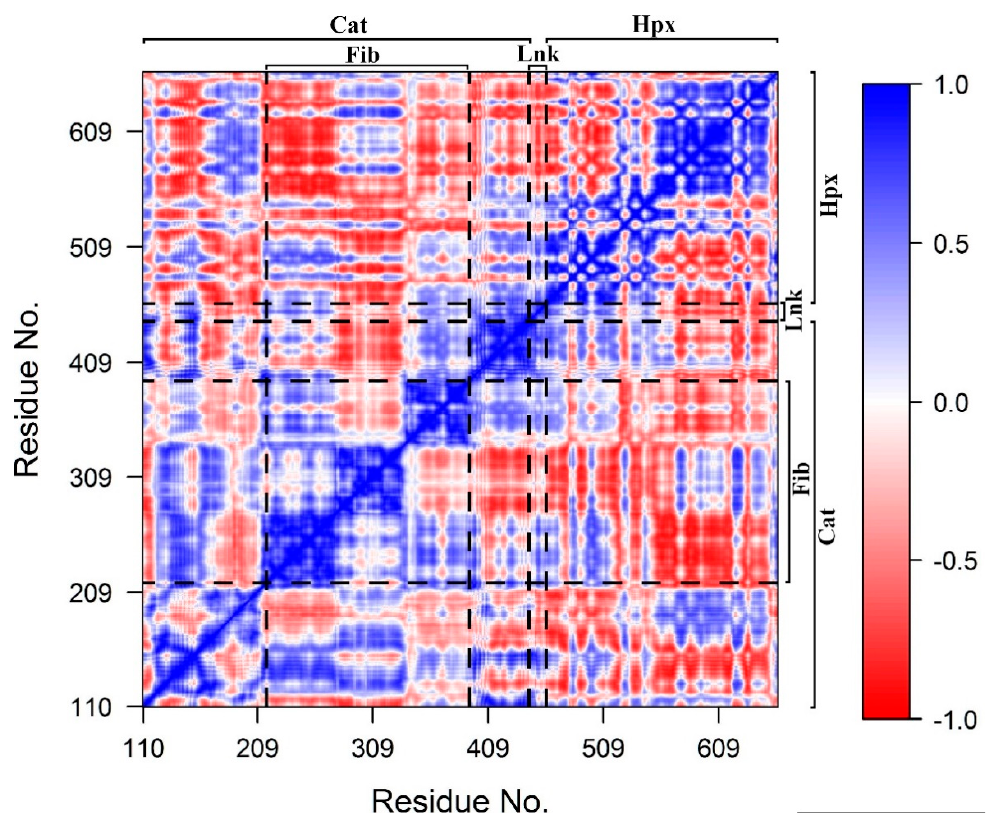
Figure 5. Dynamic cross-correlation matrix. Values range from -1 (complete anti-correlation) to +1 (complete correlation). The Cat, Fib, and Hpx domains and Lnk regions are demarcated with dashed lines. Table 5. Binding energies between MMP-2 and the associated divalent cations as determined by the MMPBSA-IE and interaction entropy methods with its associated components.